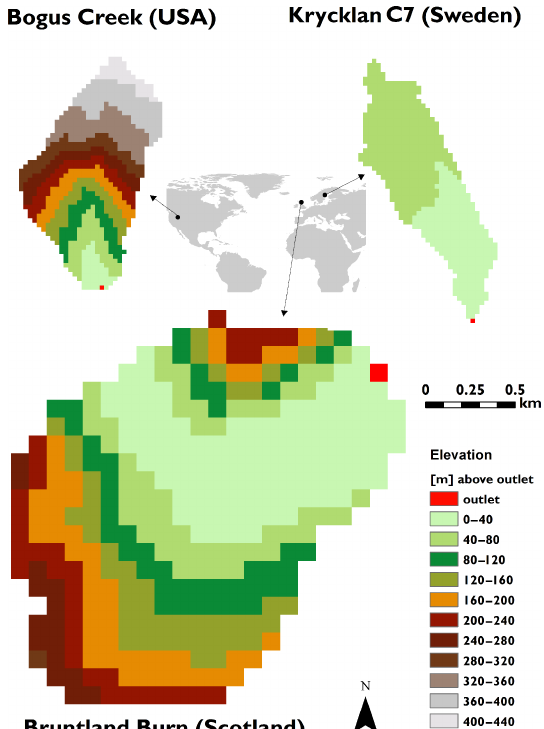
Figure 1. Study sites in same scale for size and same colour scheme for altitude, and location of the sites. Pixel size in the figure equals the cell size of the model (25m for Bogus and Krycklan, 100m for